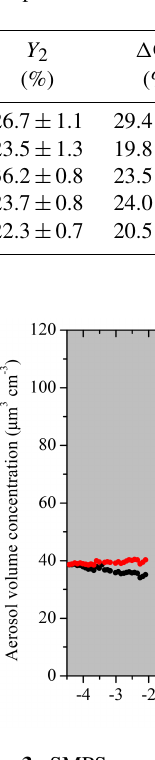
Figure 2. The size-dependent particle wall-loss rate constant pro- file, k ( D p ) , for Exp. 1. The black symbols are the rate constants calculated based on the wall-loss process of the initial ammonium sulfate seed particles from t =− 4.5h to t = 0h, while the red open symbols show those of the additional ammonium sulfate particles at the end from t = 4.5h to t = 8.5h. The blue line is the fit deter- mined.